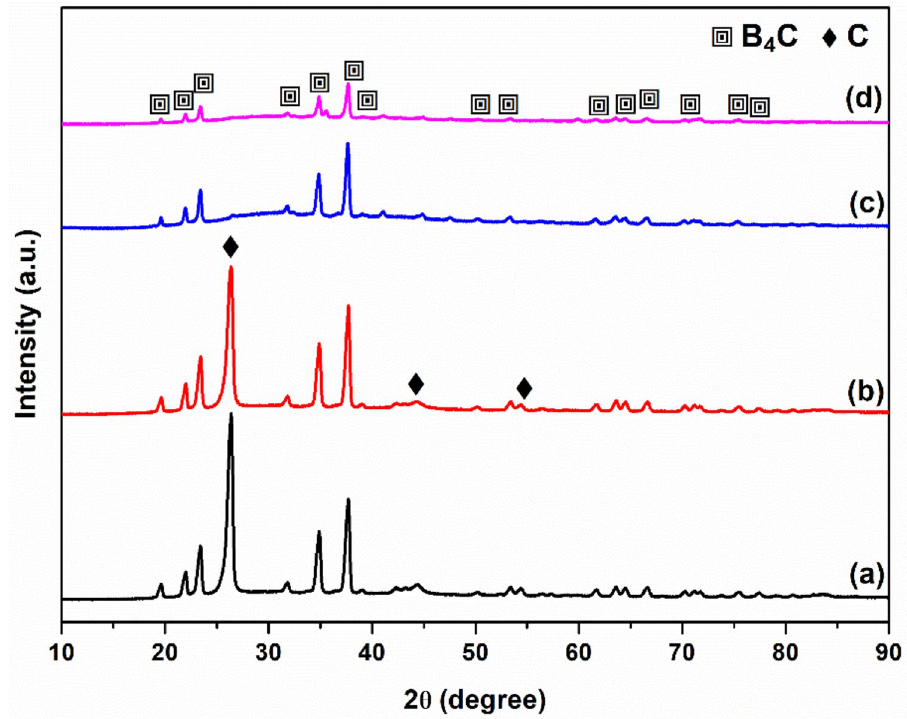
Figure 3. XRD patterns of the synthesized B 4 C powders: ( a ) S1@G3, ( b ) S2@G6, ( c ) S3@A3, and ( d )